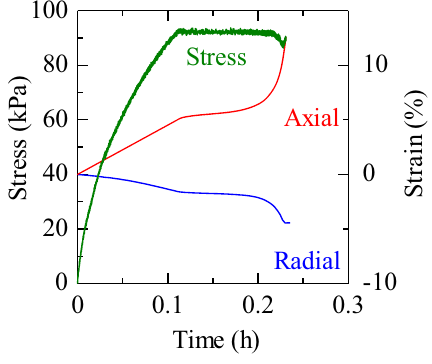
Fig. 8 Distribution of UCS. A mixed specimen of A and B was counted as 0.5 A and 0.5 B